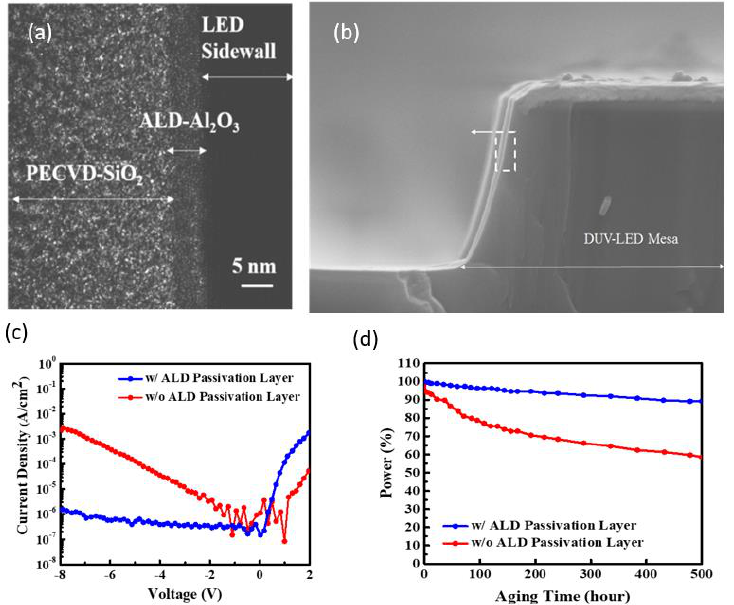
Figure 6. Mesa surface of DUV chip coated with SiO 2 /ALD-Al 2 O 3 film for passivation, ( a ) partial enlarged view of side wall, and ( b ) mesa cross-section view ( c ). Comparison of I-V curves of DUV chips with or without ALD-Al 2 O 3 film, and ( d ) comparison of aging at RT and 60% humidity between DUV chips.